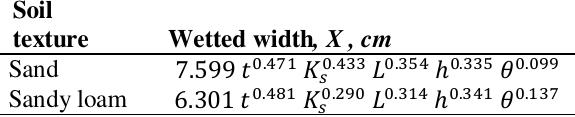
Empirical formulas to predict the wetted